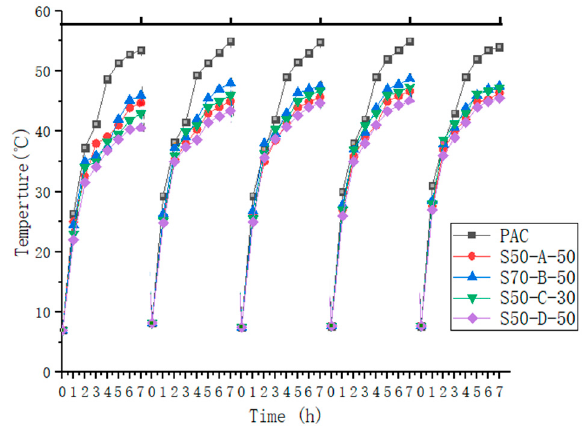
Figure 12. The surface temperature of the five mixtures.